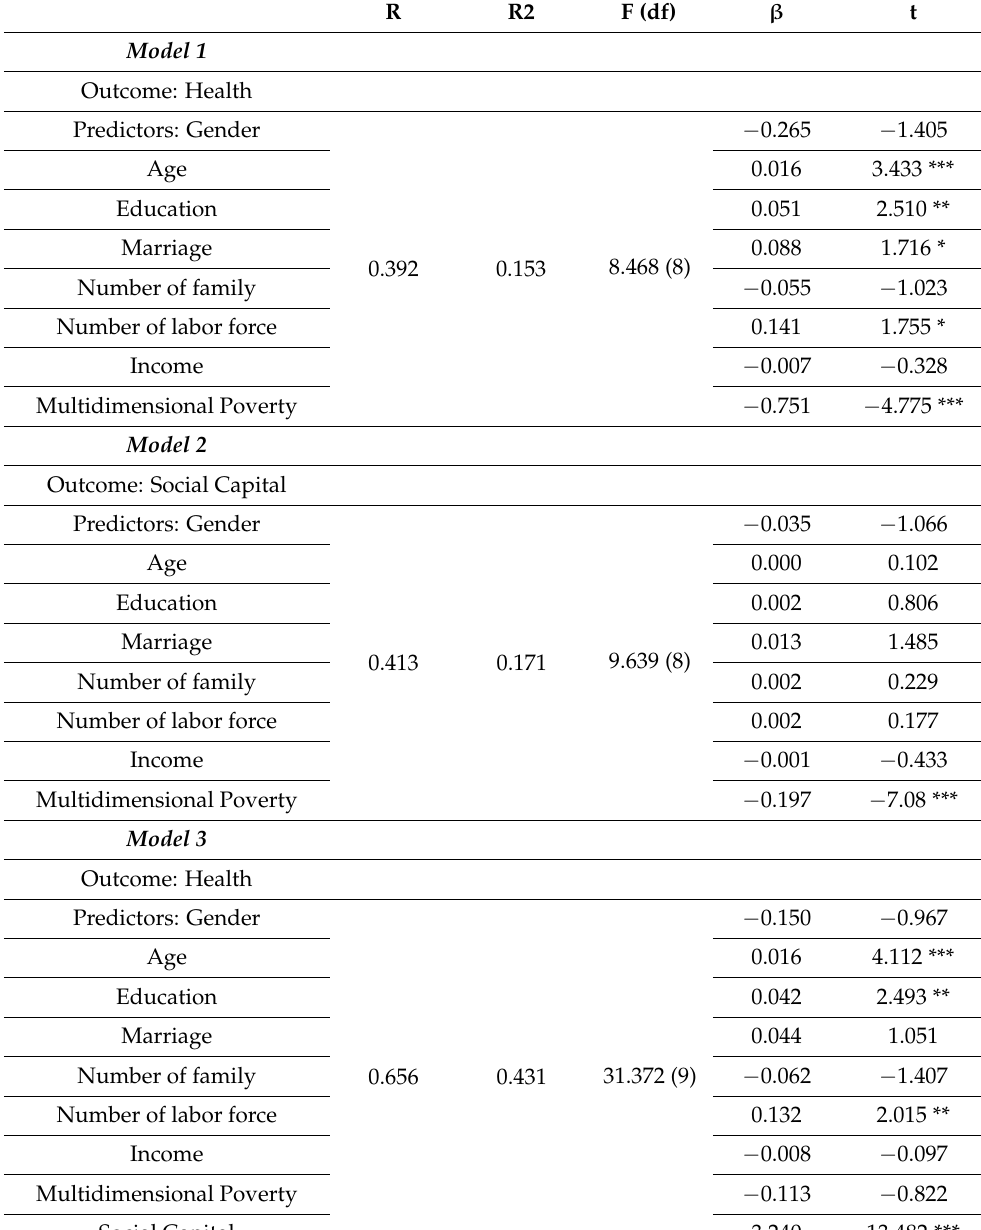
Table 4. Regression analysis of the mediating role of social capital.